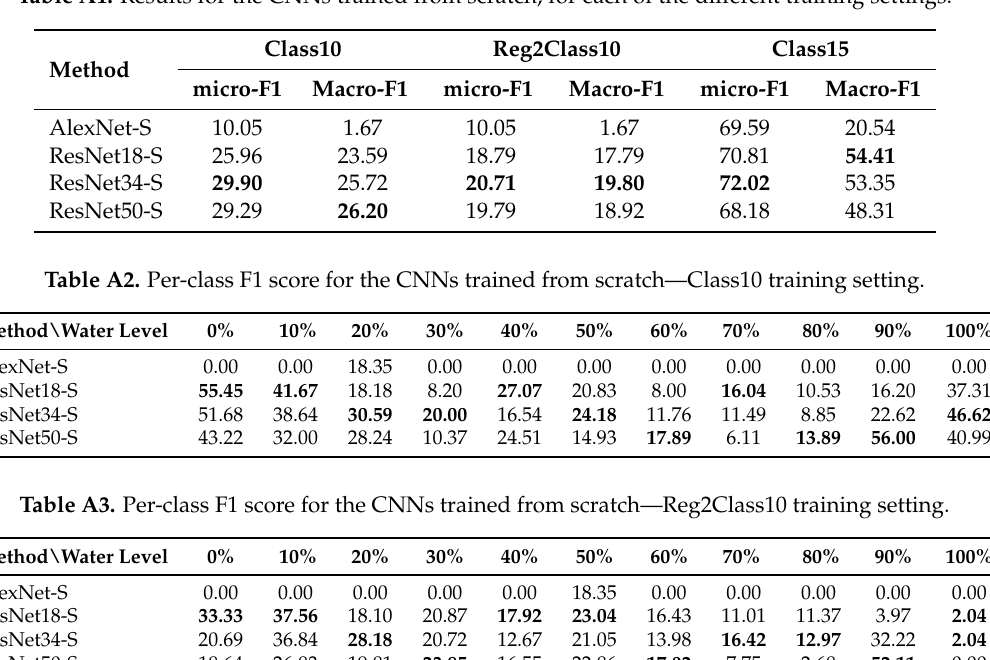
Table A1. Results for the CNNs trained from scratch, for each of the different training settings.